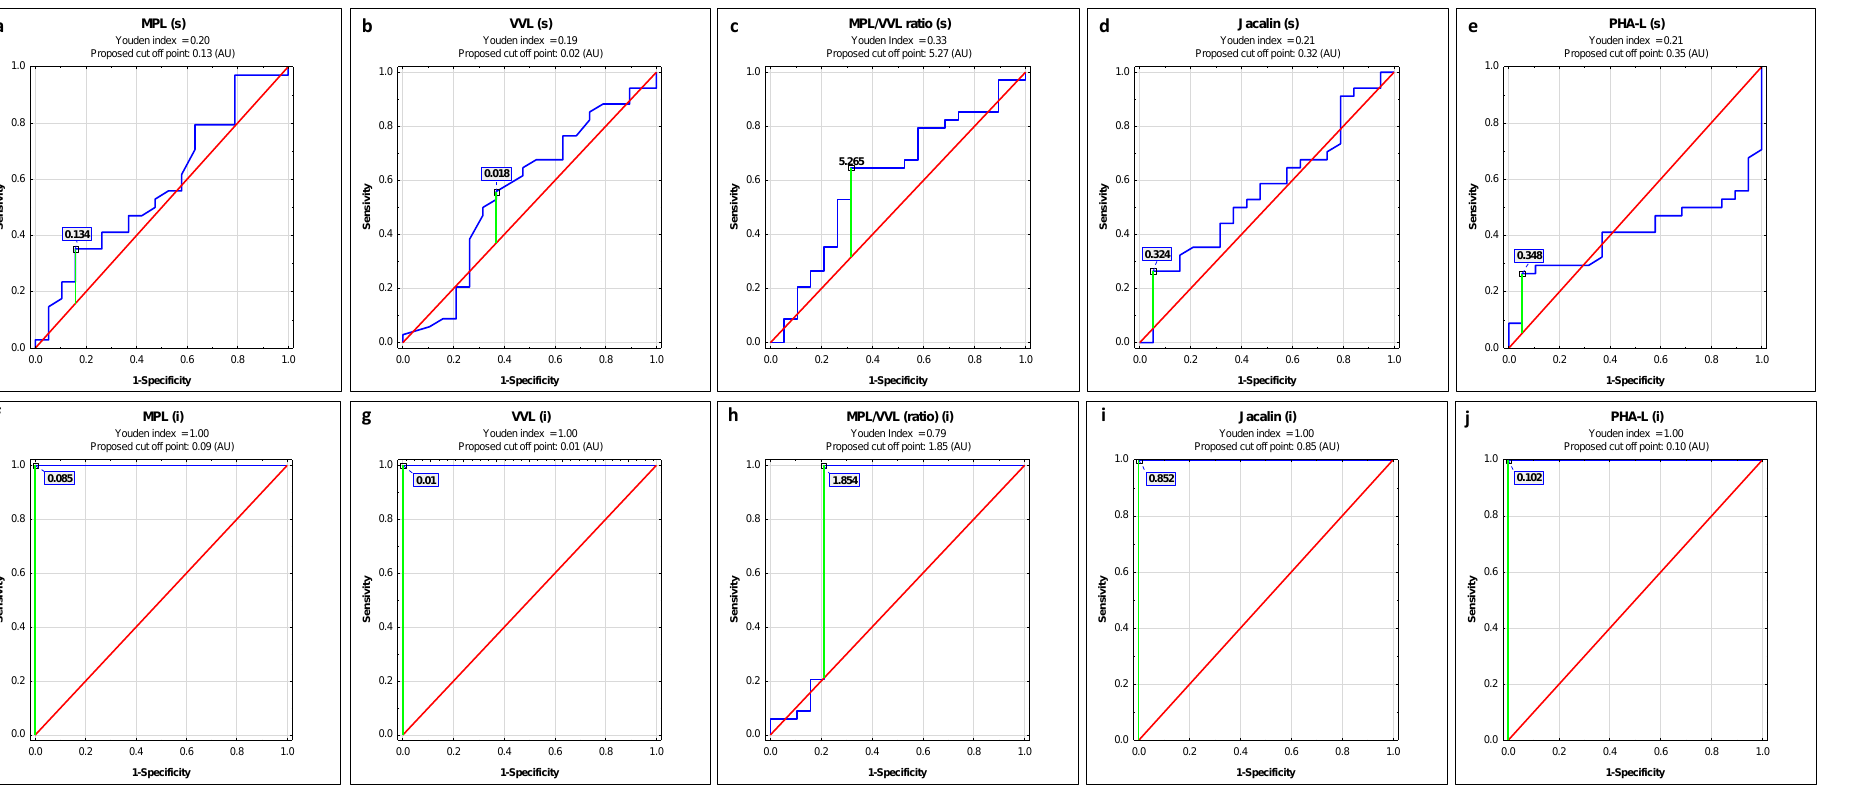
Figure 3. ROC curve analysis of s-IgG and i- IgG glycans’ relative reactivities with lectins for women with advanced endometriosis and healthy subjects ( a – j ). The reference line is marked in red, the receiver operating characteristics for the parameter in blue, and the cut-off point in green, MPL — Maclura pomifera lectin, VVL — Vicia villosa lectin, MPL/VVL — O-glycosylation ratio, Jacalin — Artocarpus integrifolia lectin and PHA-L — Phaseolus vulgaris leucoagglutinin. For specificity of lectins see Materials and Methods section.